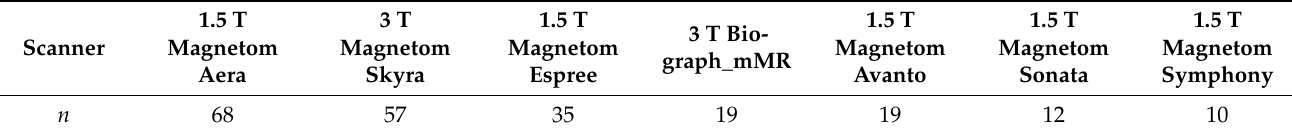
Table 2. Distribution of examinations among MR scanners (all scanners are from Siemens Healthineers).